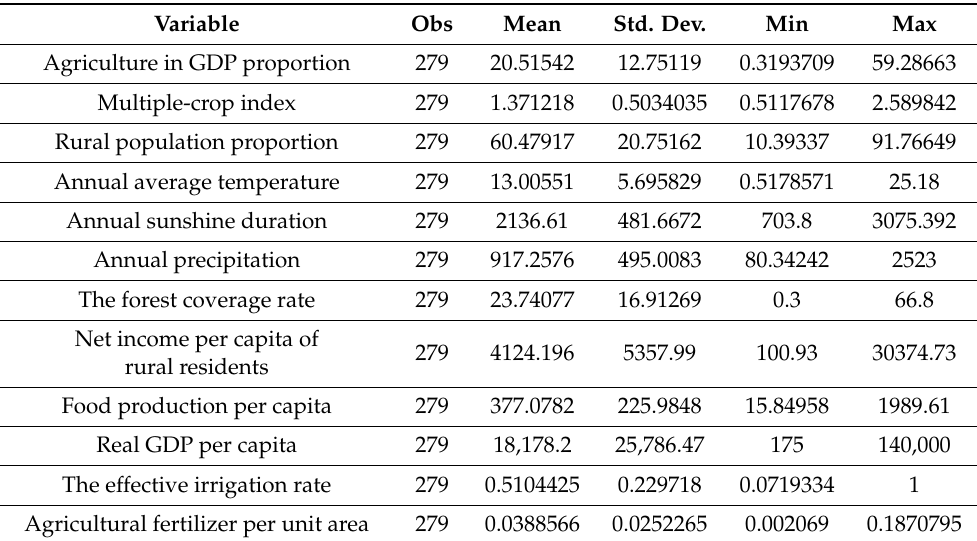
Table 2. Descriptive statistical results of